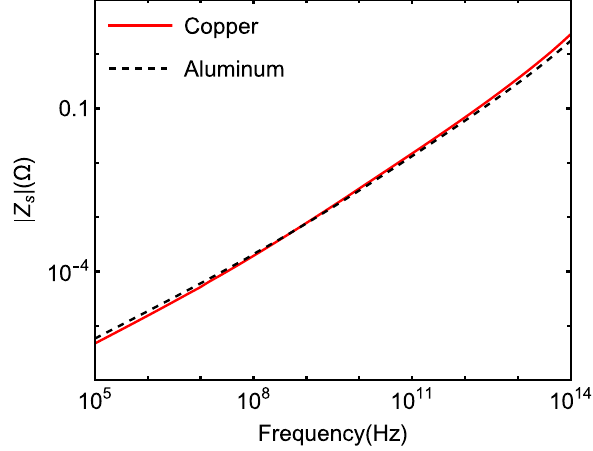
FIG. 2. Surface impedances of the anomalous skin effect (RRR ¼ 100 ) for copper and